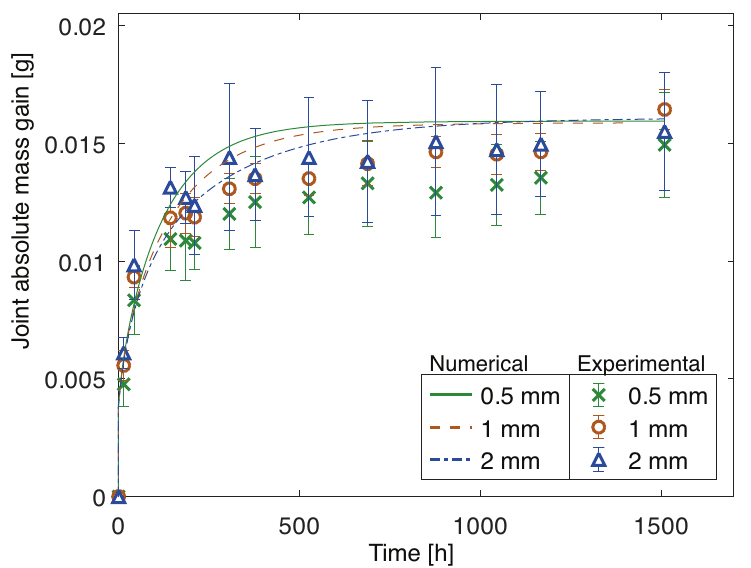
Figure 24. Mass gain due to water uptake of joints with PBT-GF30 substrates and 0.5 mm, 1 mm, and 2 mm thick adhesive: numerical (considering only water uptake through the adhesive and substrate) and experimental (considering adhesive, substrate, and